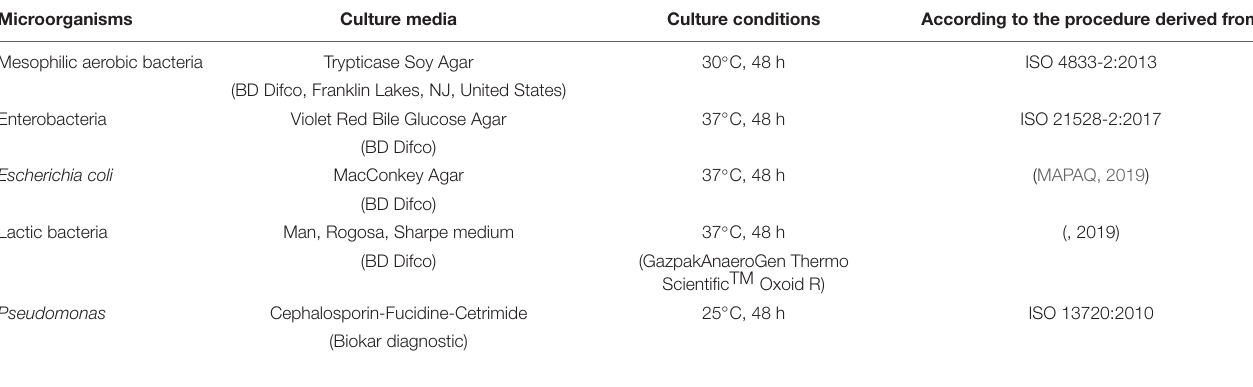
TABLE 1 | Culture conditions for the enumeration of mesophilic aerobic bacteria, Enterobacteria, Escherichia coli , lactic bacteria, and Pseudomonas.